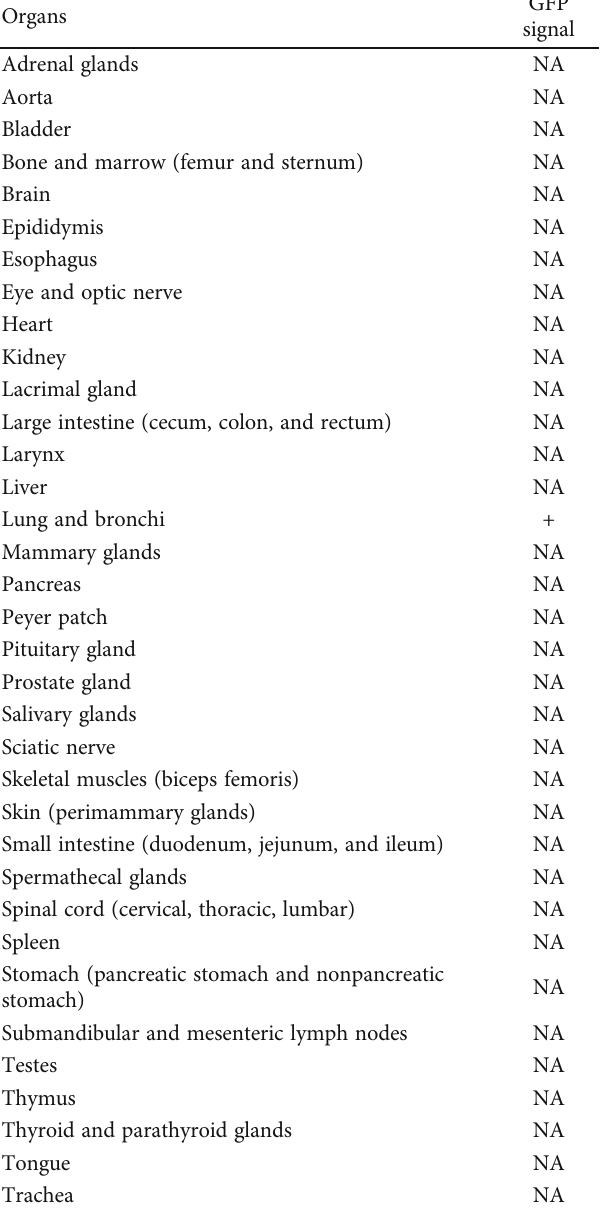
Table 1: Fluorescent examination of macaque